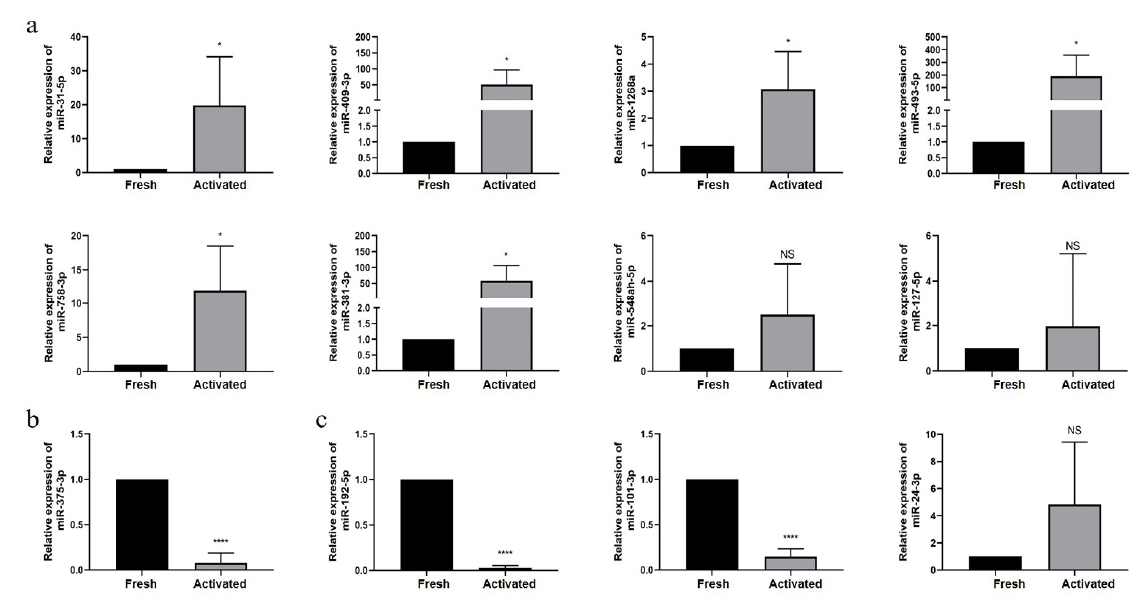
Figure 4. QRT-PCR validation of the expression of miRNAs. QRT-PCR validation of the expression of ( a ) miRNAs associated with liver diseases, ( b ) miR-375-3p , the miRNA associated with cirrhosis, and ( c ) miRNAs with contradictory expression. * p < 0.05, **** p < 0.0001, and NS, p ≥ 0.05 versus freshly isolated HSCs.